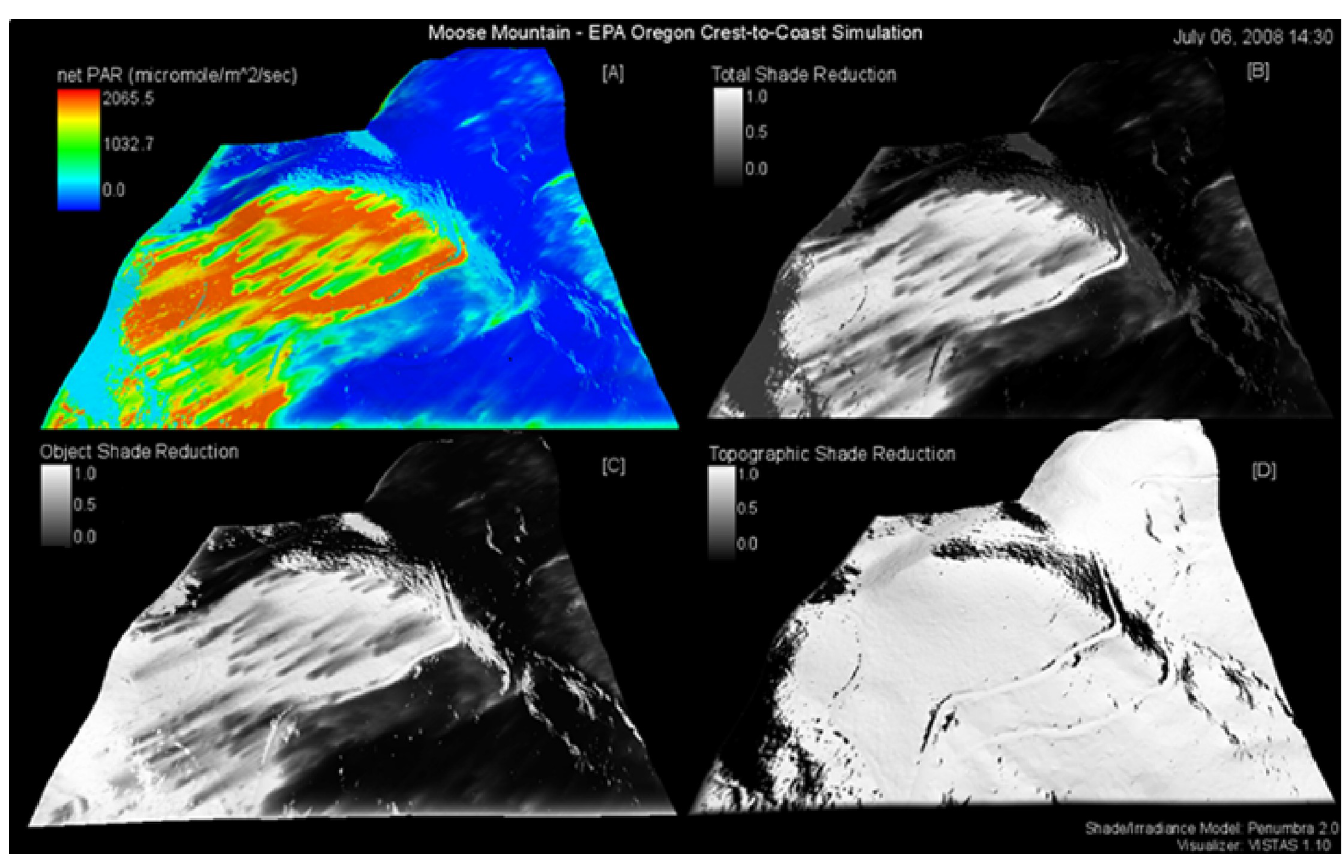
Fig 7. Moose Mountain open and forest-sites simulation still-frame. Still-frame from S1 Video of July 06th, 2008 at 2:30pm. All shade reductions are scaled from 1.0 to 0.0, where 1.0 is no reduction and 0.0 is full reduction. Sub frames: (A) net solar energy as PAR ( μ moles/m 2 /s), (B) Total shade reduction (0.0–1.0), (C) Object shade reduction (0.0–1.0), (D) Topographic shade reduction (0.0–1.0). For all (0.0–1.0) shade reductions 1.0 is no reduction and 0.0 is full reduction. See S1 Video for full animation of this simulation.